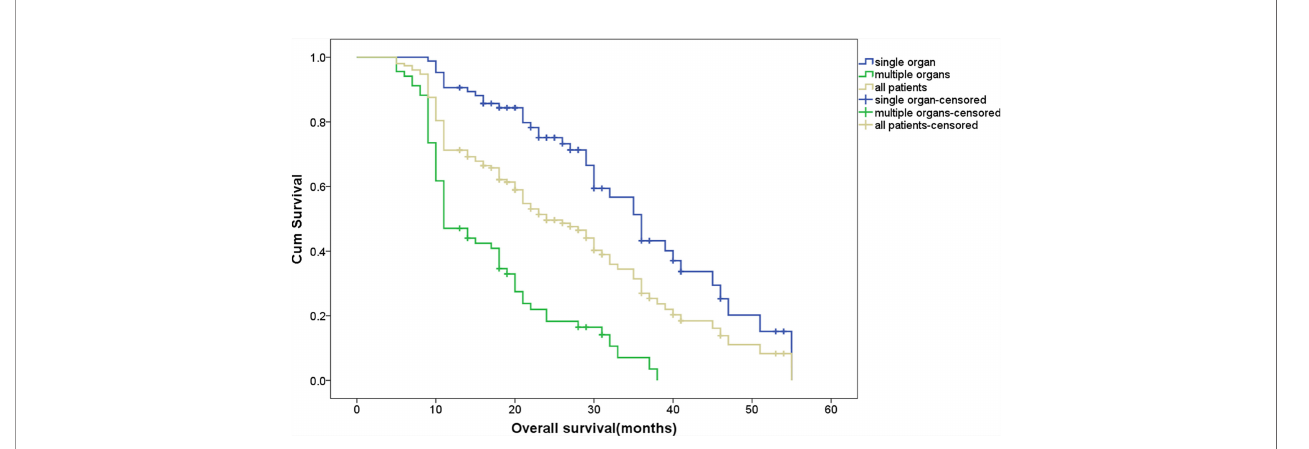
FIGURE 1 | Overall survival comparing single site and